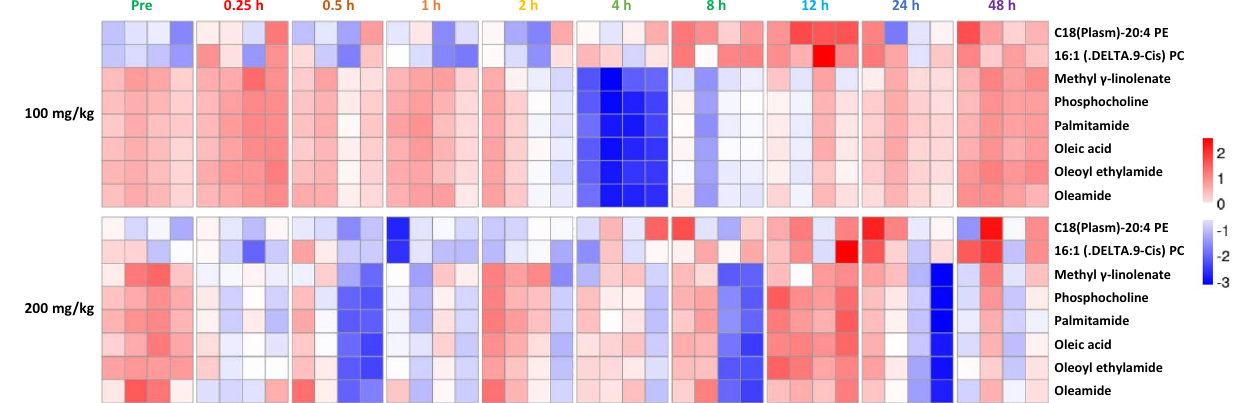
Figure 4. Hierarchical clustering based heatmap visualization of changes in serum abundance of annotated metabolites and lipids over time.